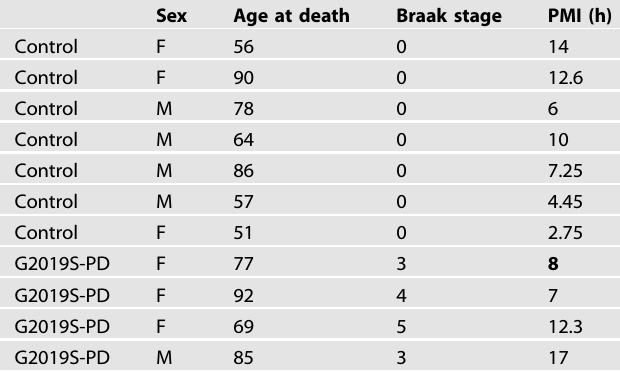
Age, gender, disease severity according to the Braak staging system (Lewy body (LB) pathology in distinct brain areas) and postmortem interval (PMI) are indicated, with no signi fi cant differences between age at death and PMI between control and G2019S-LRRK2 PD patients (mean± s.d.: